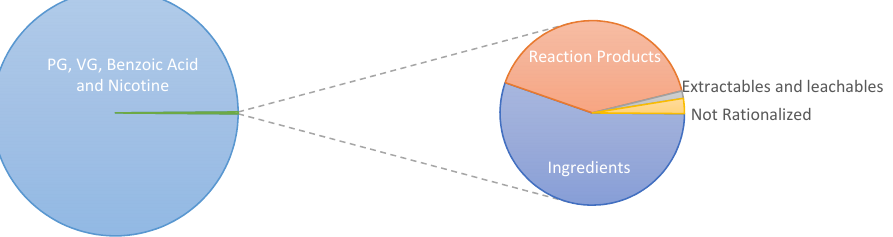
Figure 3. % Total Mass of Aerosol Constituents Detected by NTA Grouped by Type for Aerosol of VT3 Under the Intense Puffing Regimen.